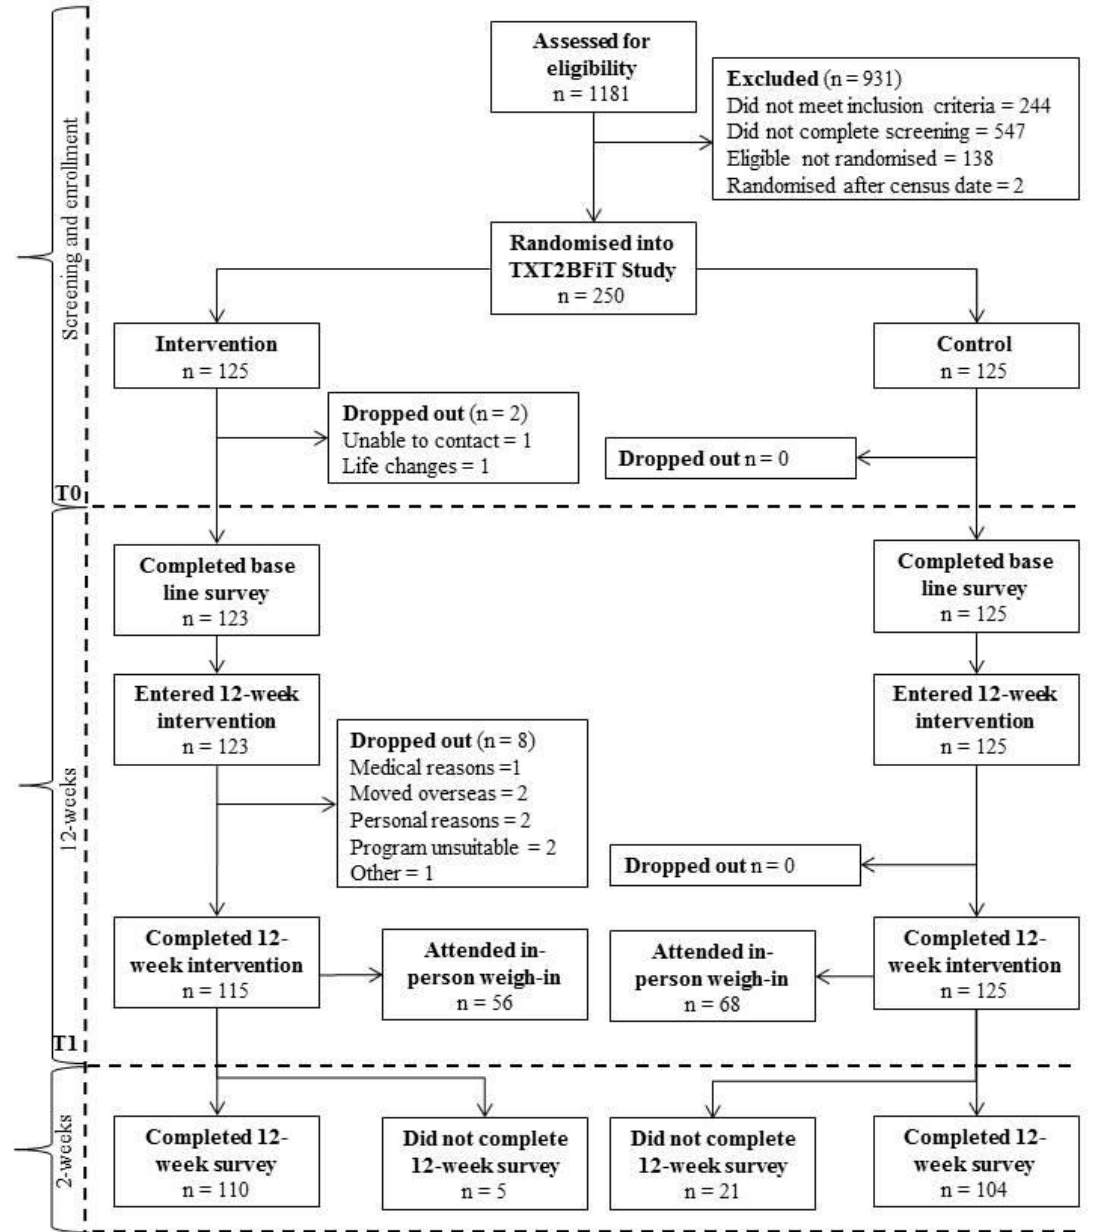
Figure 2. Flow diagram of participants in the TXT2BFiT study from week 0 to week